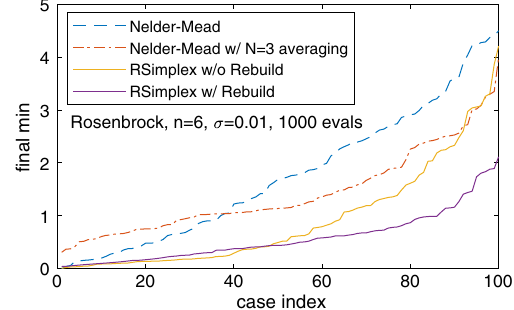
FIG. 1. Minimum function values in 1000 evaluations for the Rosenbrock problem in 100 optimization runs (sorted) with the Nelder-Mead simplex algorithm (blue dashed line), Nelder-Mead with N ¼ 3 averaging (red dash-dot line), the robust simplex algorithm without simplex rebuilding (RSimplex w/o Rebuild, solid yellow line) and with simplex rebuilding (RSimplex w/ Rebuild, solid magenta line).